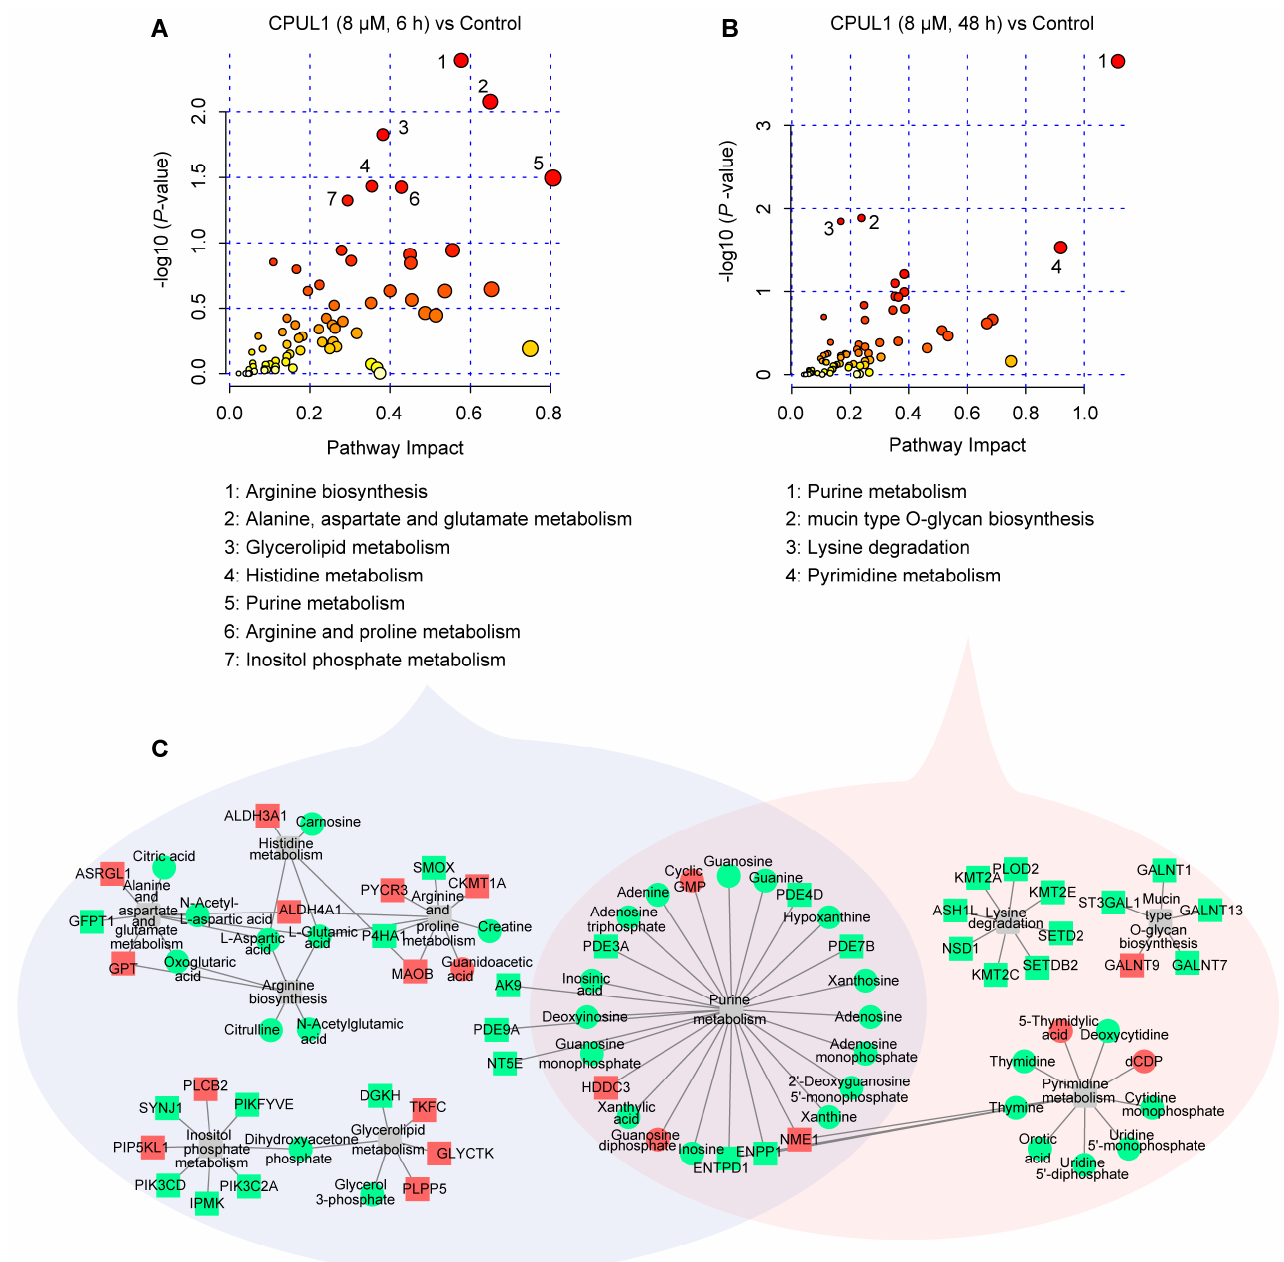
Figure 6. Integrated analysis of the mechanism underlying the effects of CPUL1 treatment on BEL- 7402 cells based on the metabolomic and transcriptomic data. Pathway analysis was generated using MetaboAnalyst 5.0 based on differential genes and metabolites. ( A ) The 6 h-CPUL1-treated group. ( B ) The 48 h-CPUL1-treated group. ( C ) Visualization of the pathways comprised of genes and metabolites. The square dots represent genes, and the round dots represent metabolites. Red and green represent the upregulation and downregulation, respectively. Edges represent the functional connections between the pathways and genes or metabolites.